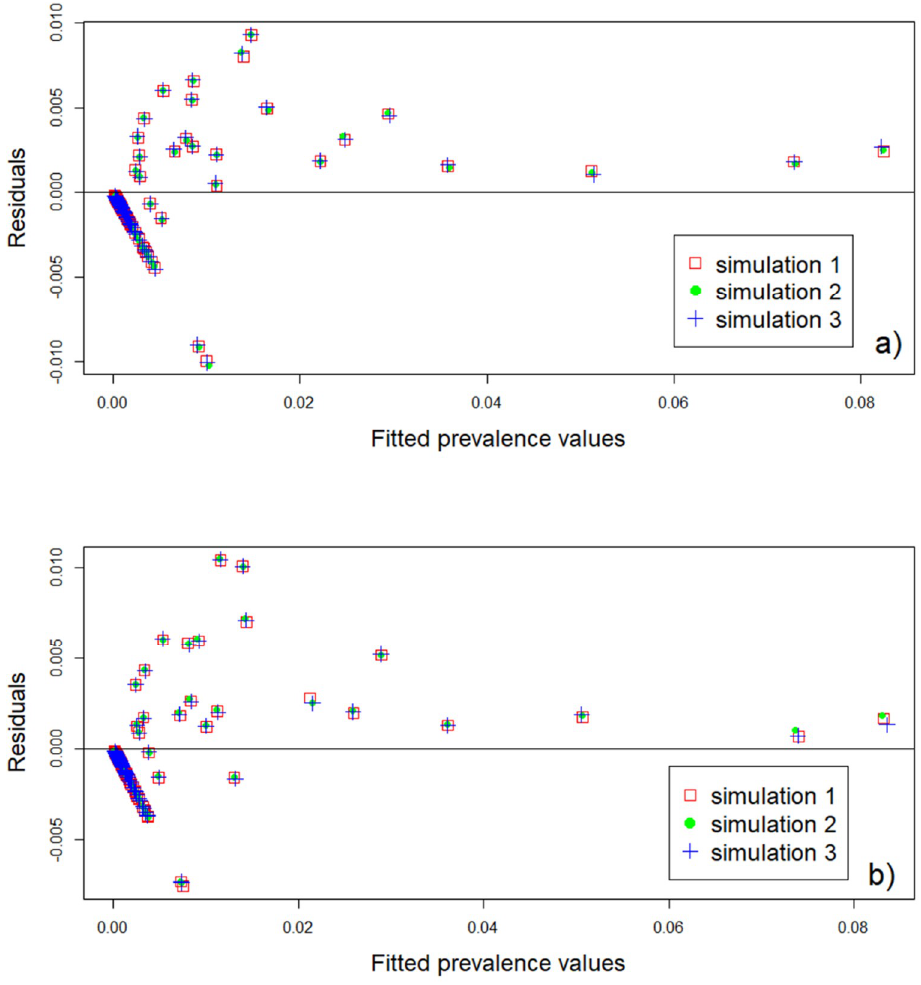
Figure 3. Residual plots for the ( a ) convolution and ( b ) ecological models.